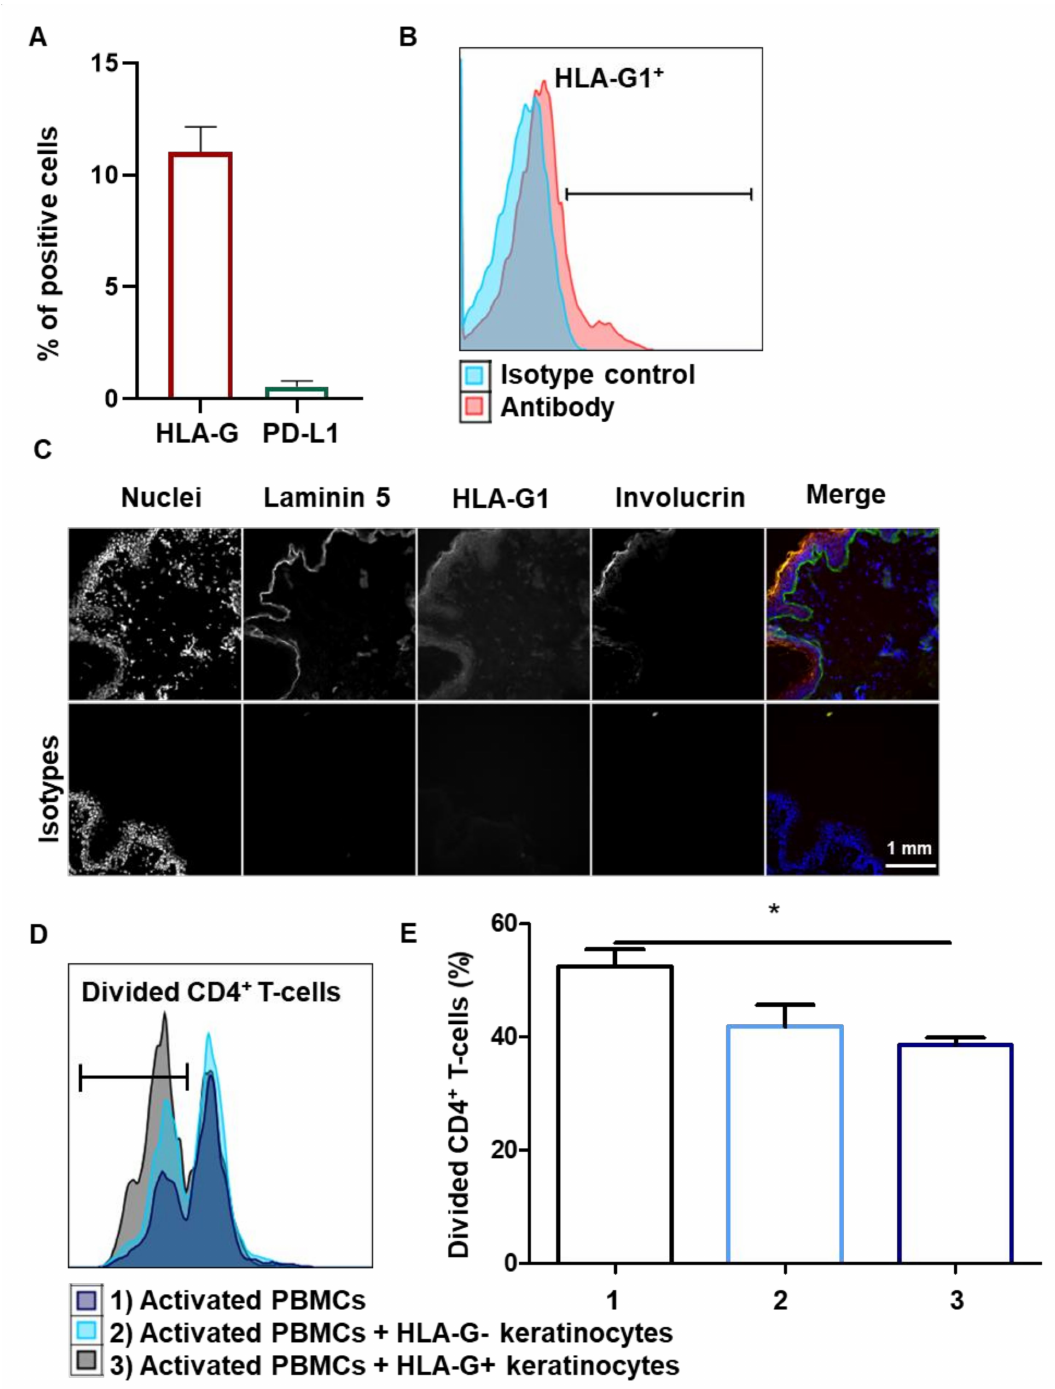
Figure 5. Tissue keratinocytes express HLA-G1, making them immunomodulators. ( A , B ) Cells from 9 representative adult donors were extracted. ( A ) Analysis by flow cytometry of PD-L1 and HLA-G1 expression on keratinocytes (mean + SEM, n = 9). Exact p-values were determined via Wilcoxon matched-pairs signed rank test. ( B ) Representative profiles of HLA-G1 (87G) expression on keratinocytes just extracted from tissue. ( C ) Expression of HLA-G in the whole epidermis (immunohistochemistry). Laminin 5 is a basal lamina marker and involucrin is a horny-layer marker. ( D , E ) In total, 10,000 keratinocytes just extracted from tissue, sorted as HLA-G − or HLA-G + , were incubated with 100,000 PBMCs for 7 days. PBMCs were activated by CD3 + CD28 + beads. PBMC proliferation was quantified by dye decrease at day 7. ( D ) Representative flow cytometry profiles at day 7. ( E ) CD4 + T-cell proliferation inhibition varied according to presence of keratinocytes and HLA-G (mean + SEM, p < 0.05, n = 3). Exact p-values were determined using the t -test. *: p <